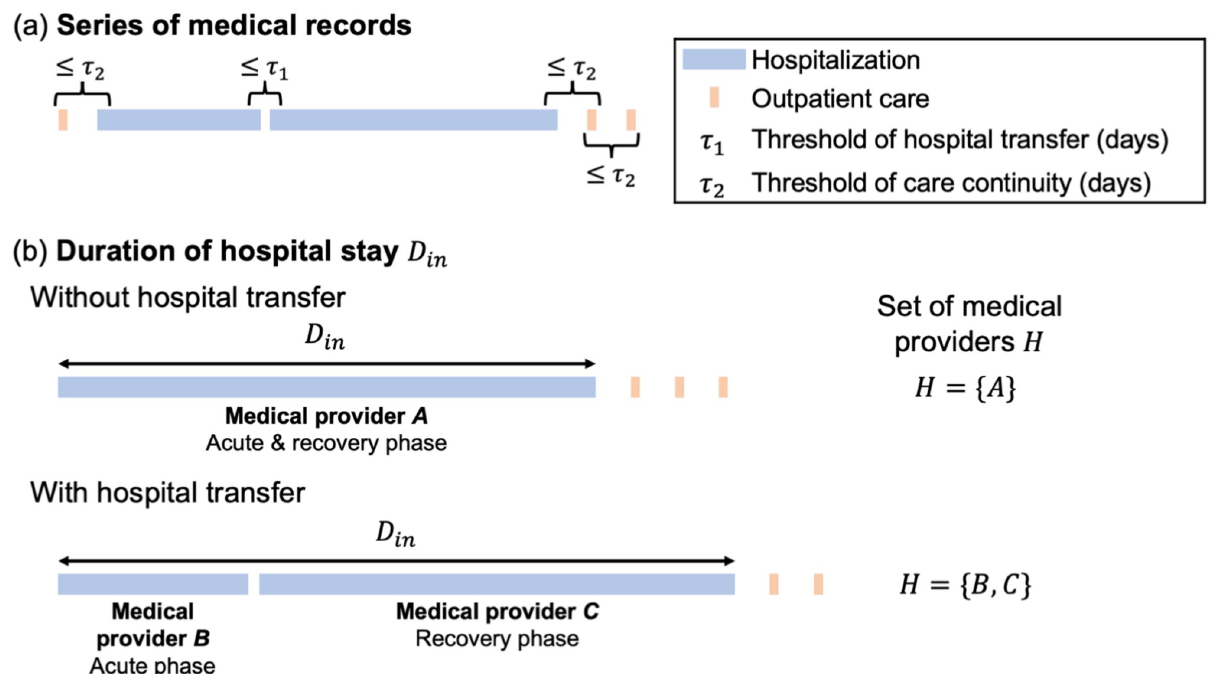
Fig 2. Methods for calculating duration of hospital stay D in . (a) Extracting a series of medical records using two types of threshold τ 1 and τ 2 . The threshold of hospital transfer τ 1 determines the inpatient transfer. The threshold of care continuity τ 2 is used to integrate pre-and post-hospitalization outpatient records into the series of medical records. (b) Calculating the duration of hospital stay D in from each series of medical records. In the case of medical records with hospital transfers, the date of admission at the first medical provider to the date of discharge at the last medical provider is D in . H denotes set of medical providers where a patient is hospitalized.